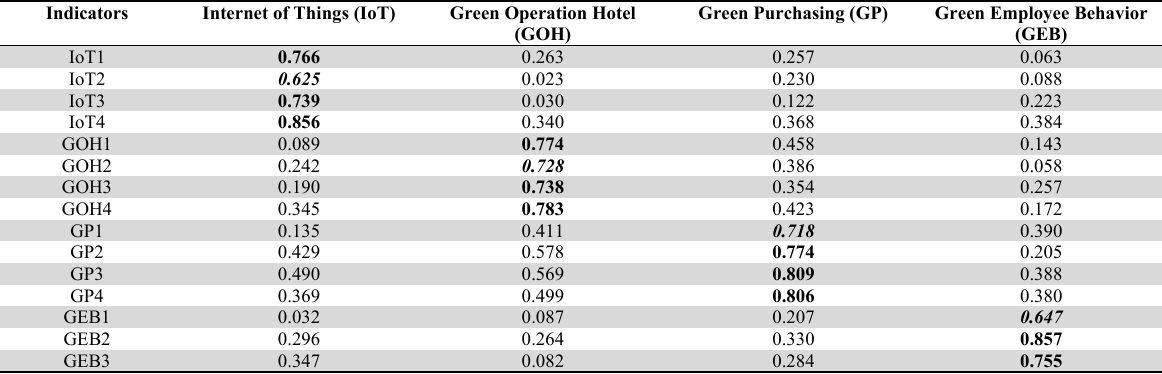
The Results of Composite Reliability